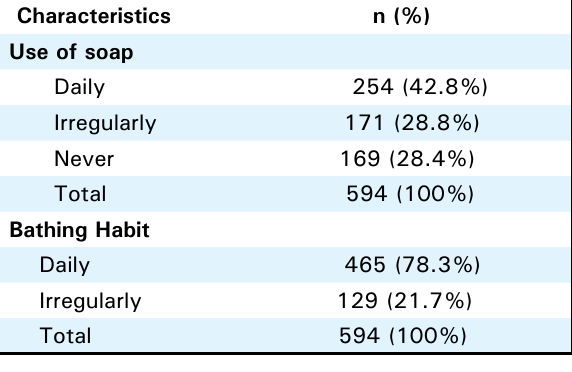
Table 4. Bathing habit and the use of soap. Characteristics